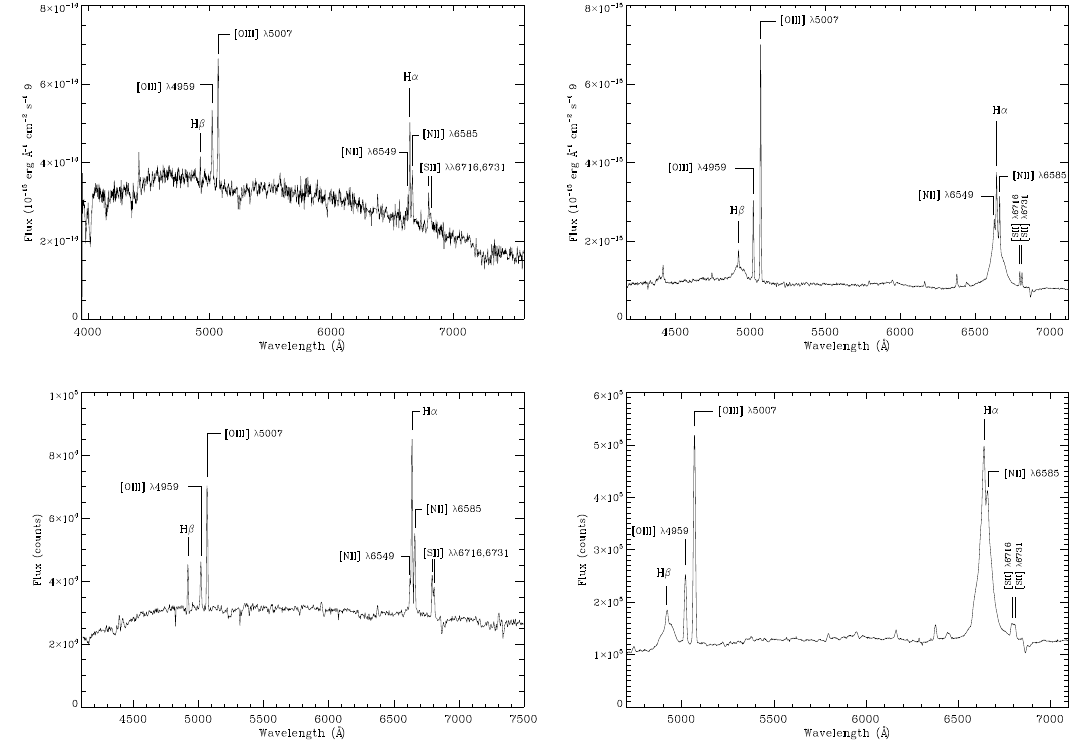
Figure 1. Four datasets of ESO 362-G18. From right to left and from top to bottom: 6dF spectrum dated 30 January 2003 [42] (Sy1.9); EMMI data dated 18 September 2004 [38] (Sy1.5); EFOSC1 data dated 21 September 2006 (Sy1.9); FORS2 data dated 29 March 2016